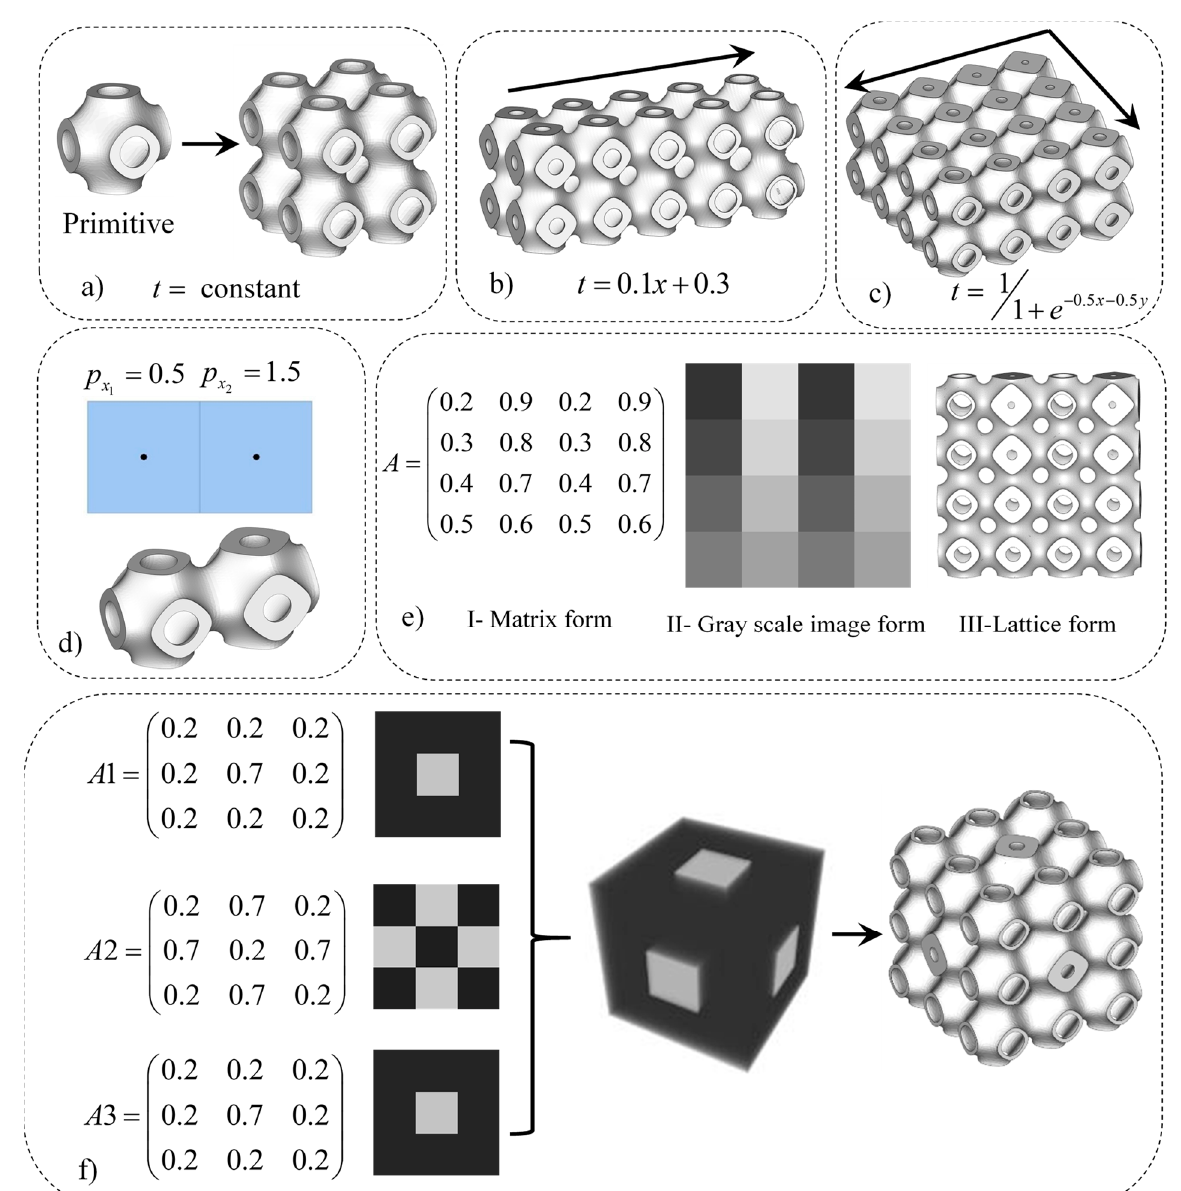
Figure 1. Minimal surface-based cellular materials and the use of control points to control relative density distribution. ( a ) Uniform, ( b ) linearly graded, and ( c ) exponentially graded in the x and y axes. ( d ) Example of two unit cells graded using control points. ( e ) Example of a matrix-based grayscale image and the corresponding graded material. ( f ) Example of grayscale image stack and the corresponding graded